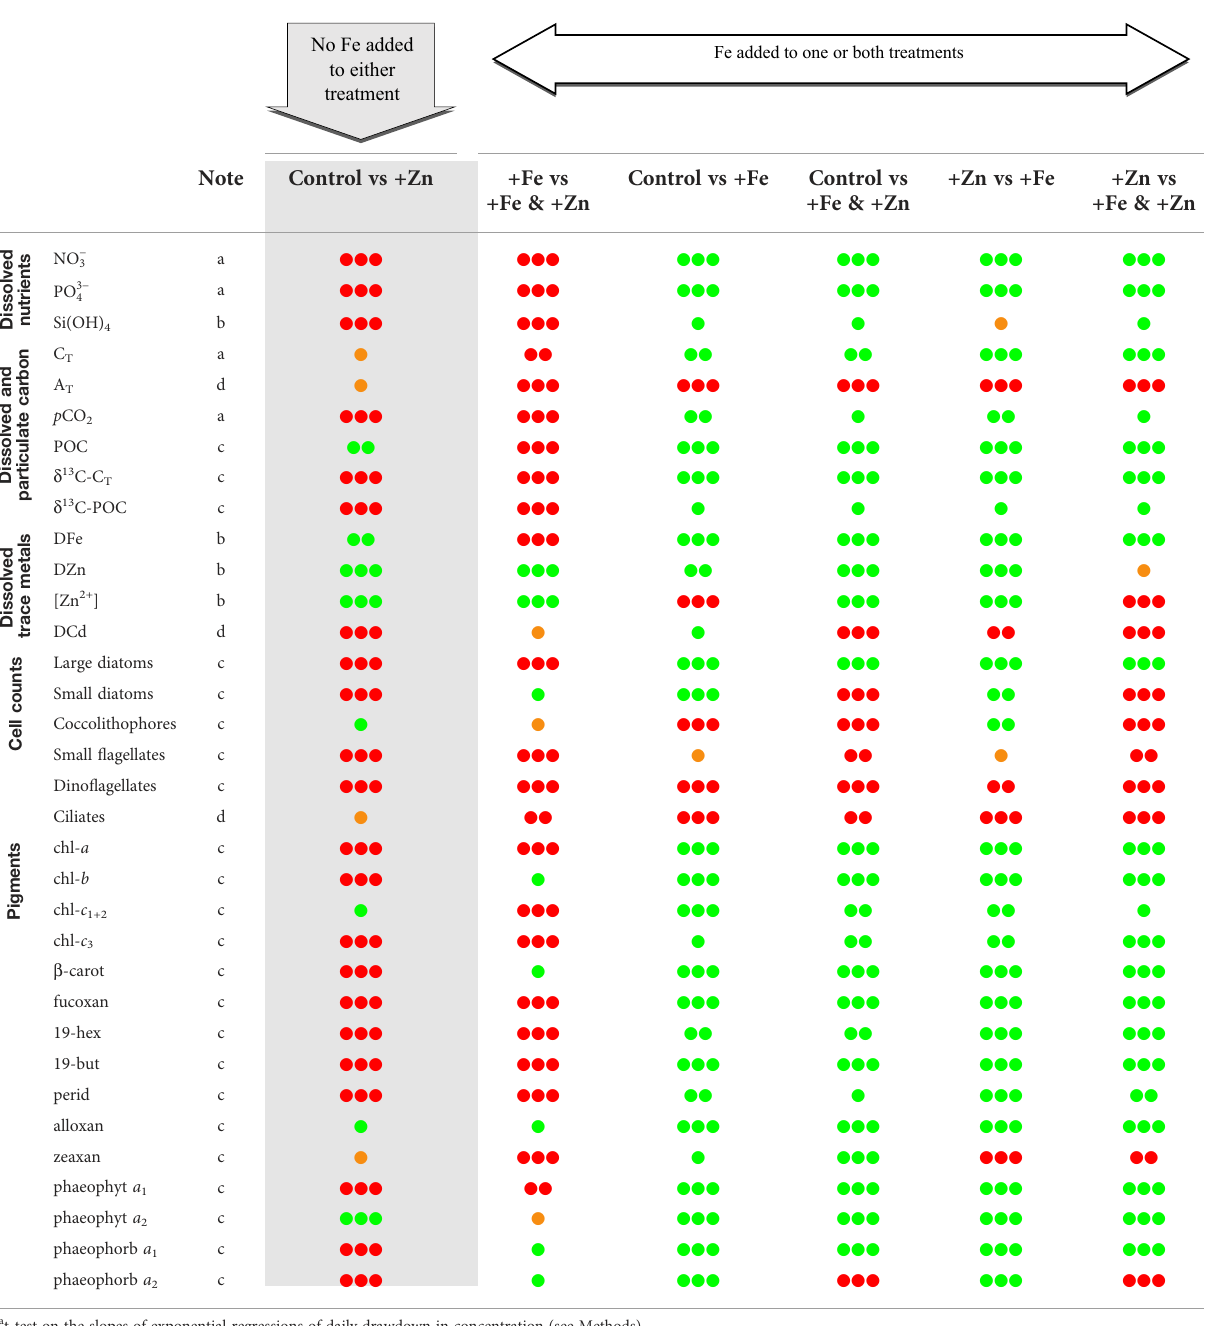
TABLE 2 Summary of statistical signi fi cance of comparisons between measurements in incubations treated with various combinations of Zn and